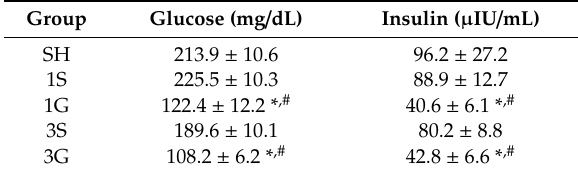
Table 4. Plasma glucose and insulin levels of the experimental groups.